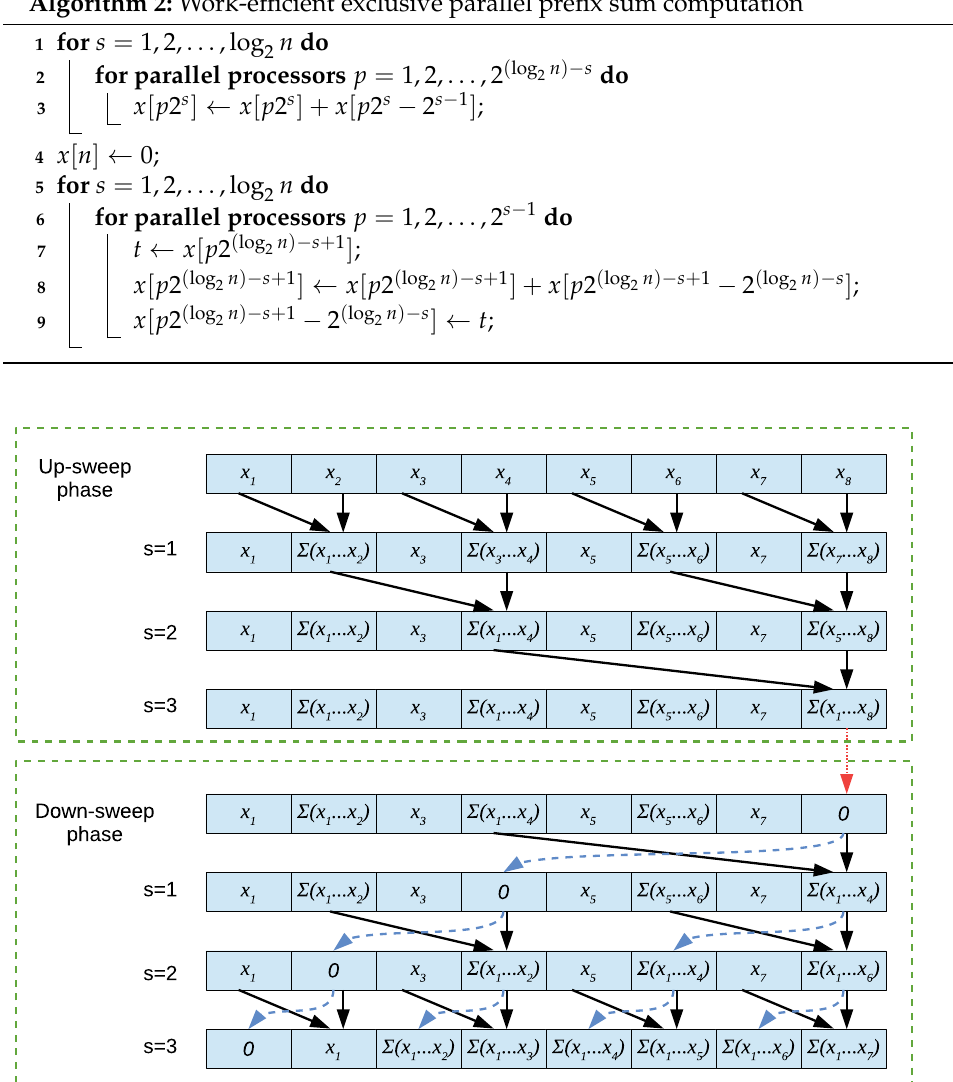
Figure 1. Work-efficient exclusive parallel prefix sum computation algorithm for k =